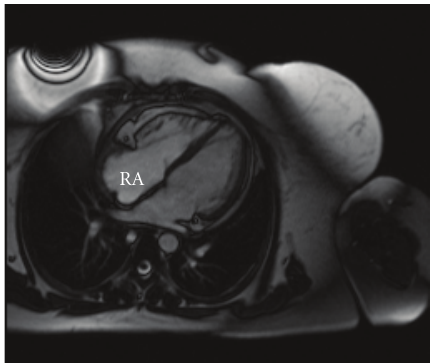
Figure 2: Cardiac MRI after chemotherapy of right atrial angiosar- coma showing significant resolution of the